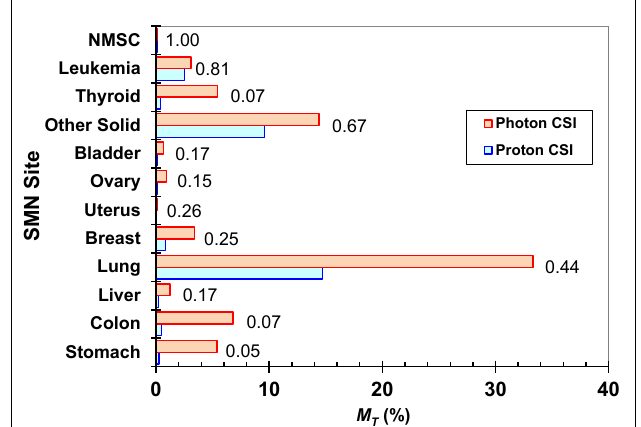
Figure 2. Site-specific predicted lifetime attributable risks of SMN incidence after photon CSI at AUBMC or proton CSI at MD Anderson. Other solid cancer risks were based on H remainder , and leukemia risks were based on H red bone marrow . These risk estimates took into account both primary and stray radiation. The ratios of the risks (proton CSI:photon CSI) are shown for each SMN site.